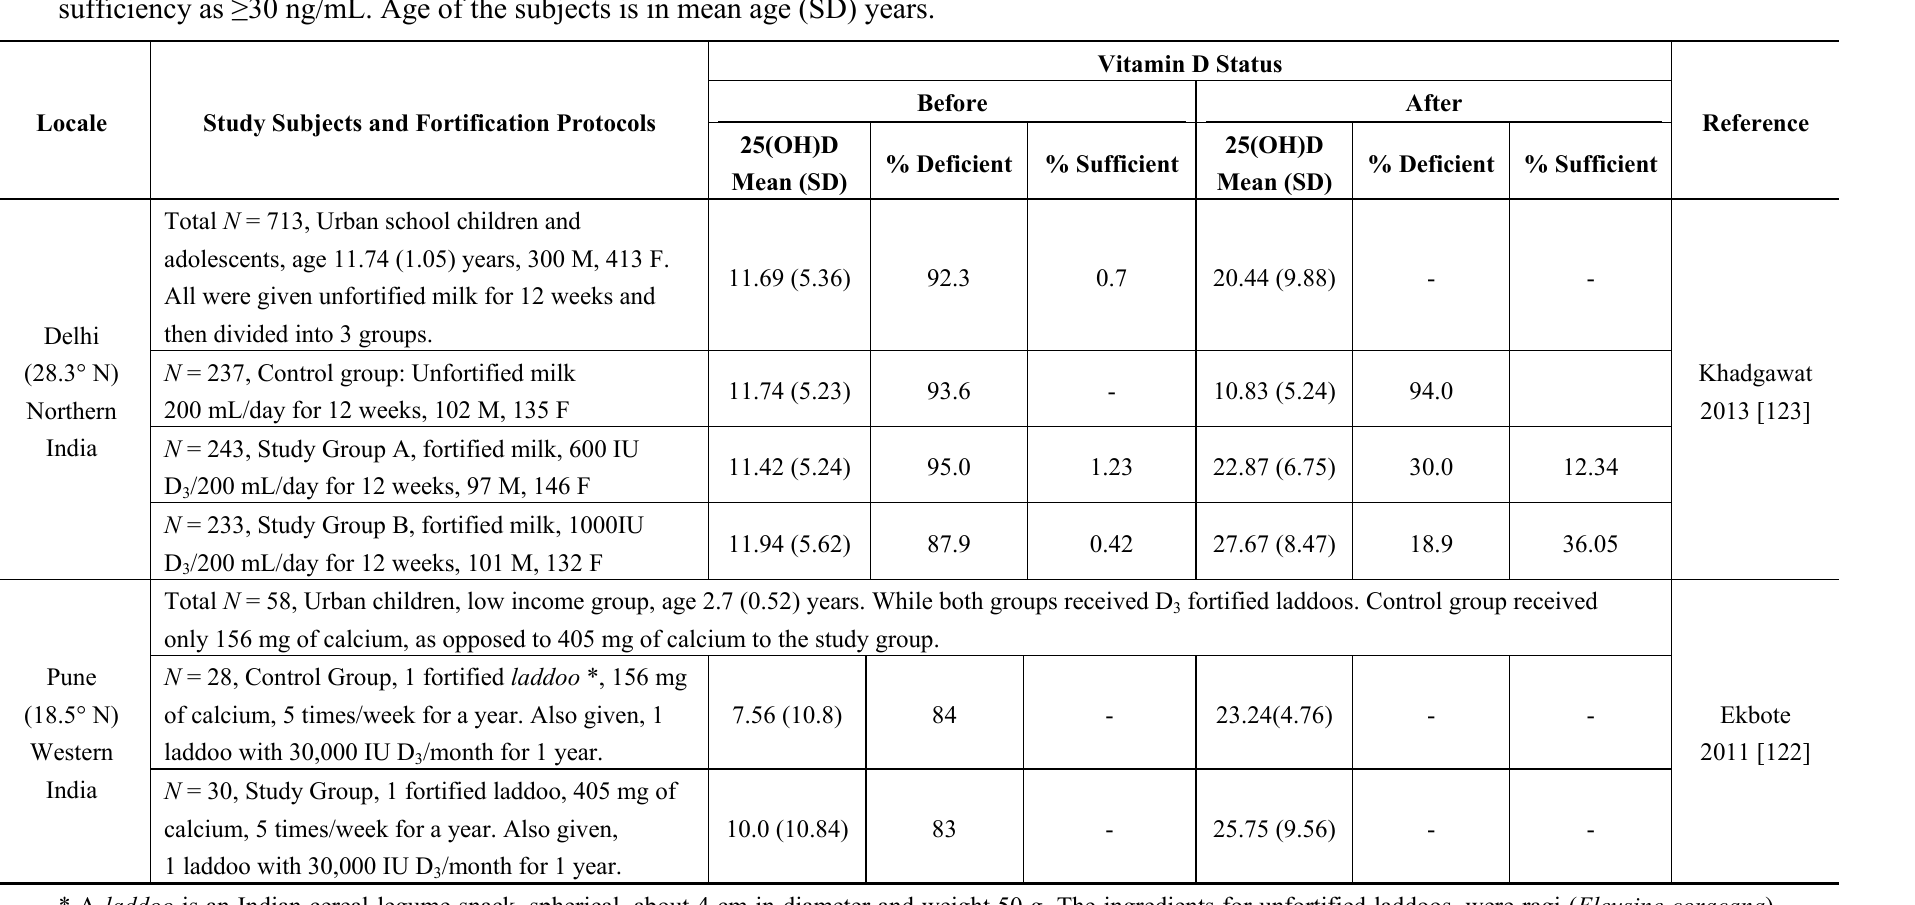
Table 5. Vitamin D food fortification studies in ostensibly healthy Indians. All 25(OH)D values have been shown in ng/mL. To convert from nM to ng/mL, nM values were divided by (2.5). Vitamin D deficiency is defined as 25(OH)D < 20 ng/mL, insufficiency as 20–29 ng/mL and sufficiency as ≥ 30 ng/mL. Age of the subjects is in mean age (SD) years.